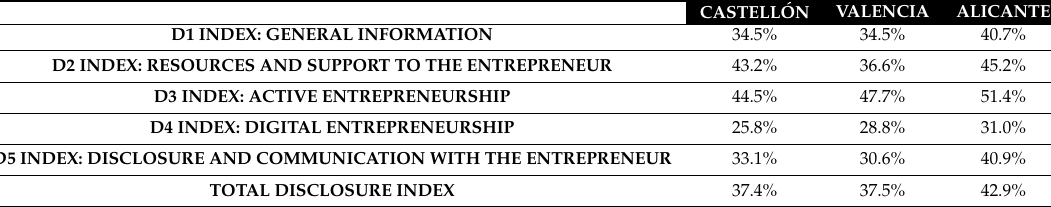
Table 5. Results of the disclosure index by province and dimension (own